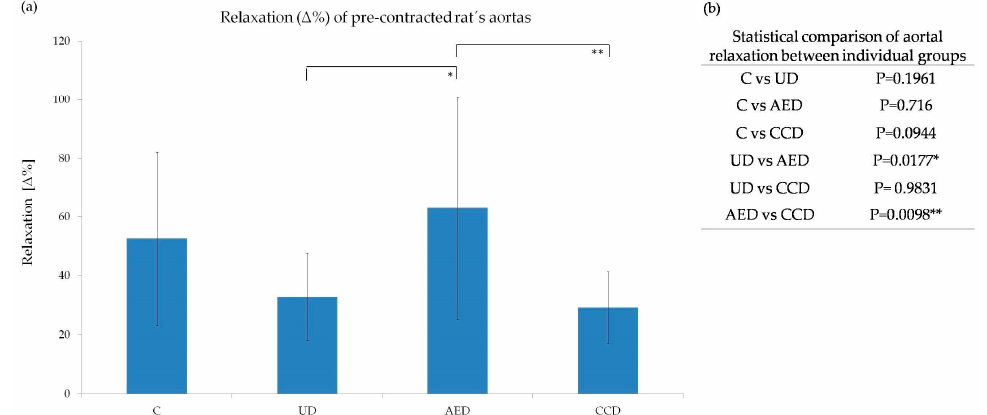
Figure 5. ( a ) Changes in reactibility of a phenylephrine pre-contracted rat’s aorta on acetylcholine (10 − 6 mol/L) after long-treated A. eupatoria and/or C. cardunculus ; ( b ) Statistical comparison of aortal relaxation between individual groups. (C—control group, UD—untreated diabetic group, AED—